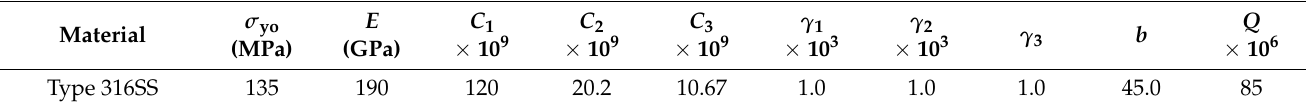
Table 10. Material constants for inelastic material models at room temperature.